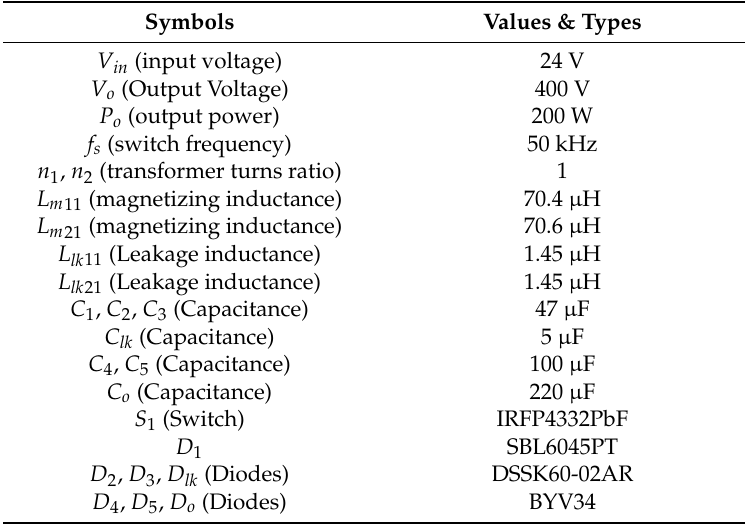
Table 1. Specifications and components used in experiments.